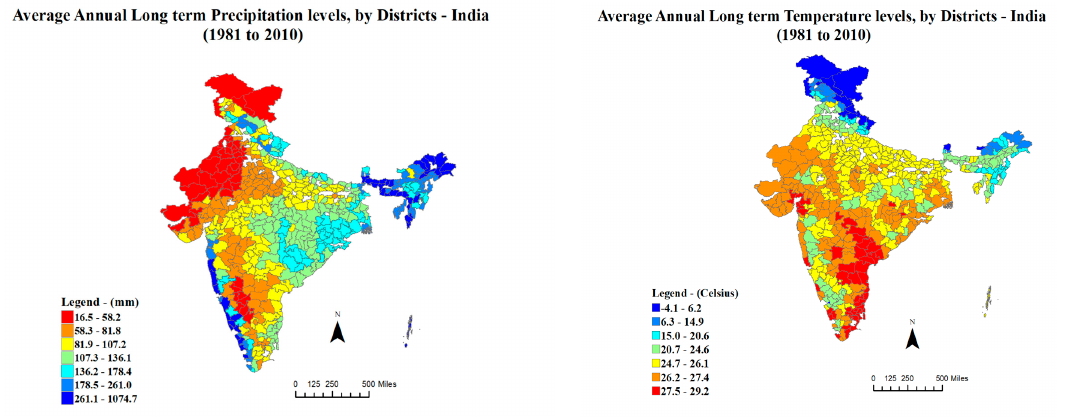
Figure 1. Average annual long-term climate patterns, by districts, in India (1981 to 2010). Left: The average annual long-term rainfall levels of all districts in India (1981 to 2010). Right: The average annual long-term temperature levels of all districts in India (1981 to